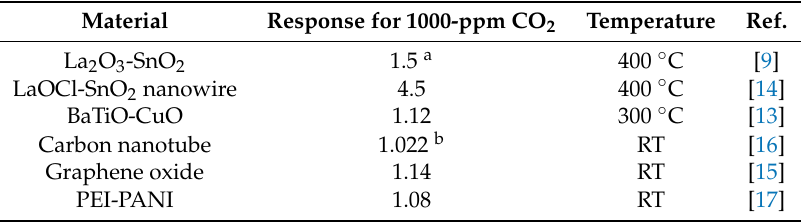
Table 1. Comparison of the properties of conductmetric type CO 2